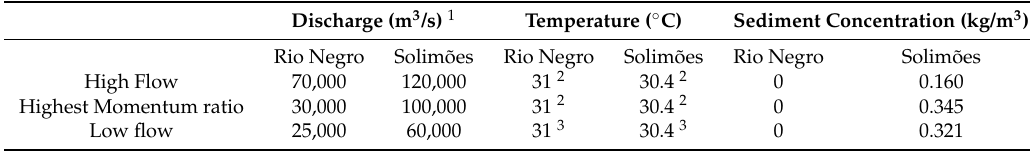
Table 2. Overview of parameters used in the model runs for the Solimões–Rio Negro confluence